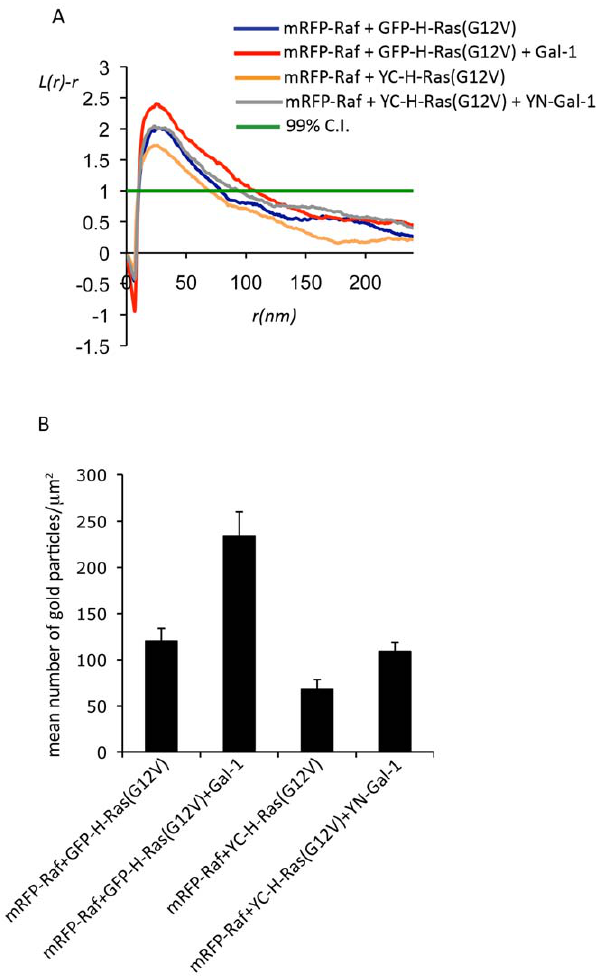
inner leaflet of the plasma membrane by H-RasG12V. Plasma membrane sheets were generated from serum-starved cells expressing the following combinations of constructs: GFP-H-RasG12V/mRFP-Raf, GFP-H-RasG12V/mRFP-Raf/Gal-1, YC-H-RasG12V/mRFP-Raf and YC-H- RasG12V/YN-Gal-1/mRFP-Raf. Theplasmamembrane sheets were labeled with anti-mRFP antibody conjugated to 5 nm gold to detect mRFP-Raf plasma membrane recruitment. A. The spatial distribution of the gold labelling was analyzed using Ripley’s K-function. Maximum L(r)-r values above the 99% confidence interval (CI) for complete spatial randomness (CSR) indicate clustering at the value of r (supr). Univarate K-functions are weighted means (n . 8) standardized on the 99% CI. B. Analysis of the number of mRFP-Raf proteins recruited to the plasma membrane. Bars represent the mean number of gold particles/ m m 2 ( 6 SEM).